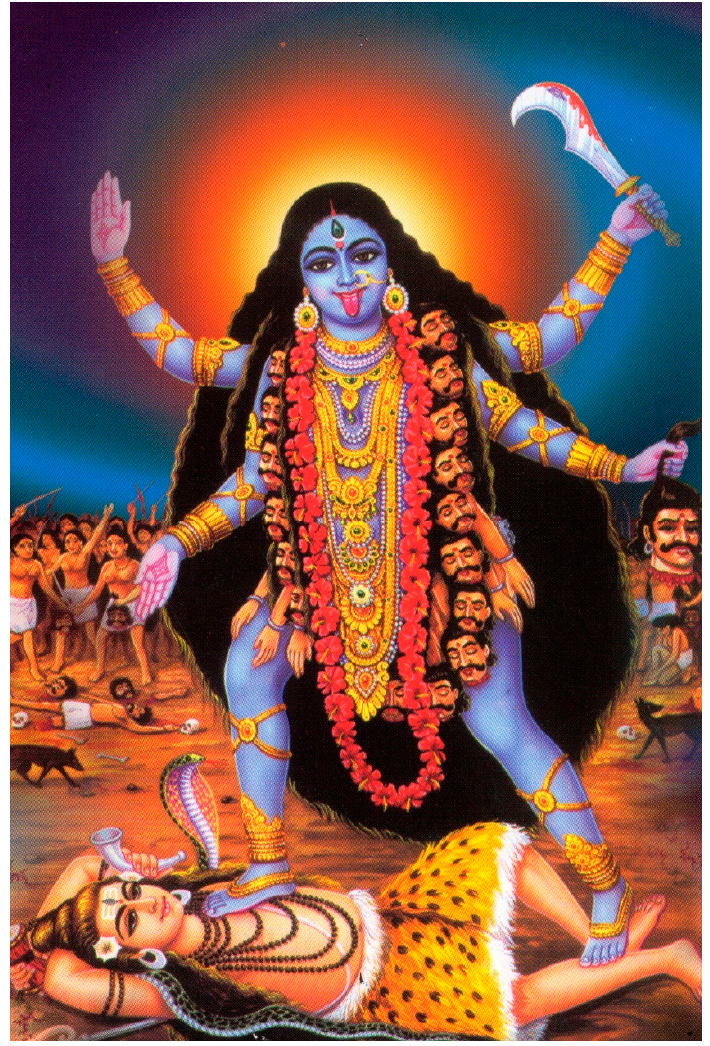
Figure 3. Postcard showing a ‘beautified’ K ā ḷ i.